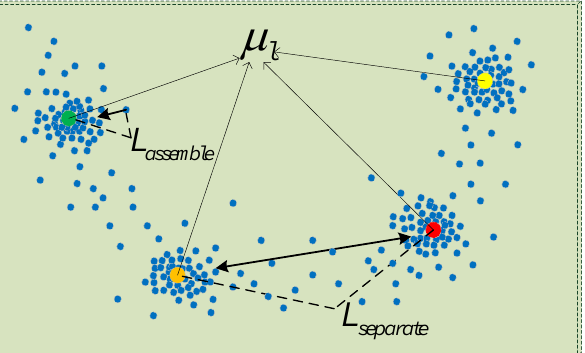
Figure 6. Associatiom embedding of key points. L assemble enables the embeddings of these key points as close as possible to the cluster center of this lane µ l . L separate is used to separate the cluster centers of different lanes.